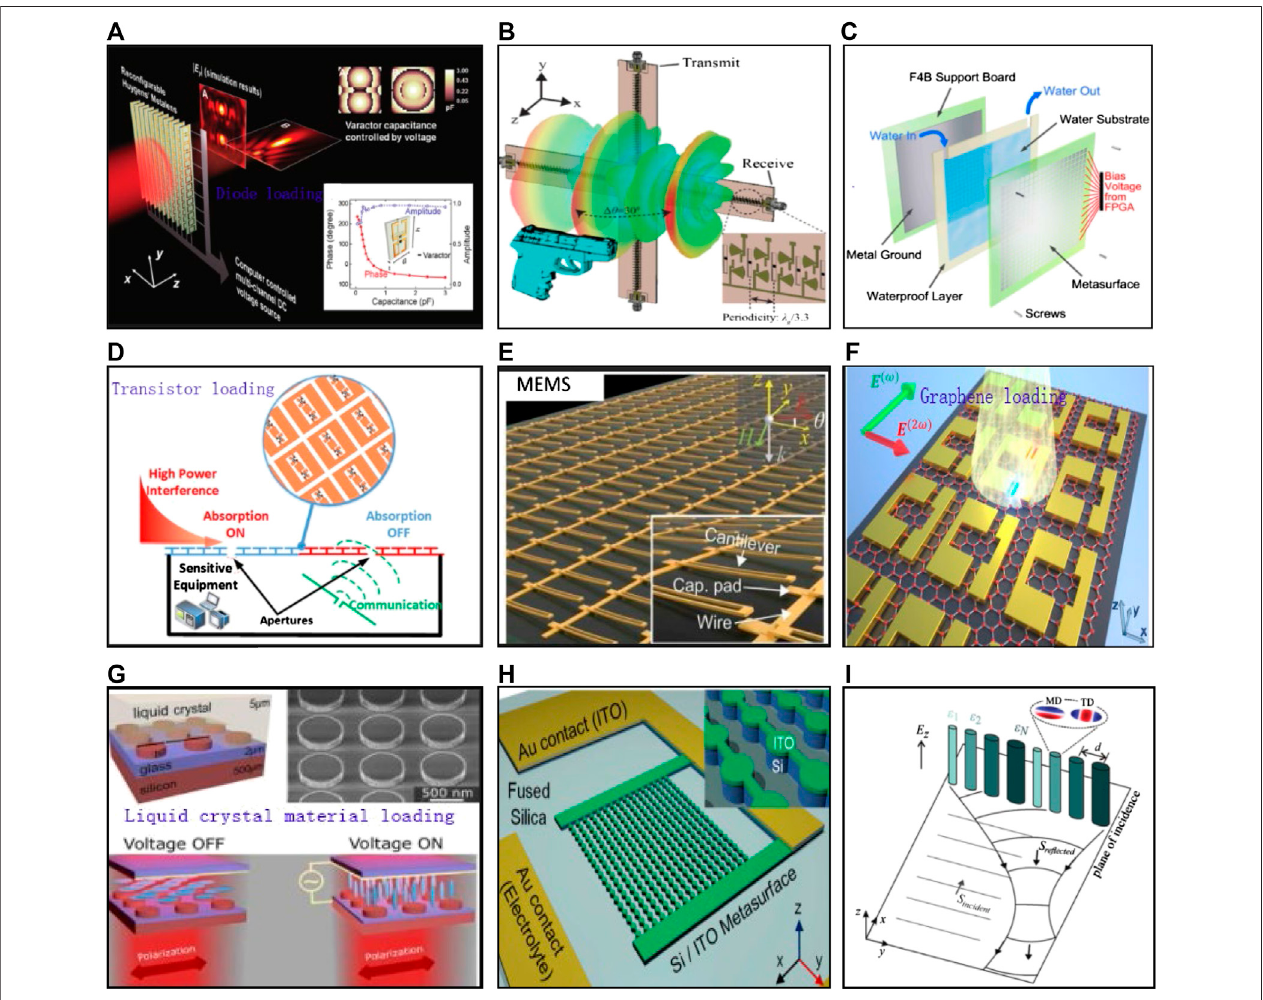
FIGURE 4 | A variety of electrically recon fi gurable metasurface designs. (A) Loaded with diodes for focal length control [104], (B) loaded with PIN diodes for microwave camera [112], (C) loaded with PIN diodes and water for X-stage wave front control [114], (D) loaded with transistor switchable absorbing control [105], (E) loaded with MEMS for polarization control [106], (F) loaded with graphene for different functions switching [109], (G) loaded with liquid crystal for recon fi gurable multiband spin-selective light absorption [110, 111], (H) loaded with ITO for focus control [125], and (I) loaded with magnetic dipole for recon fi gurable wave front manipulation